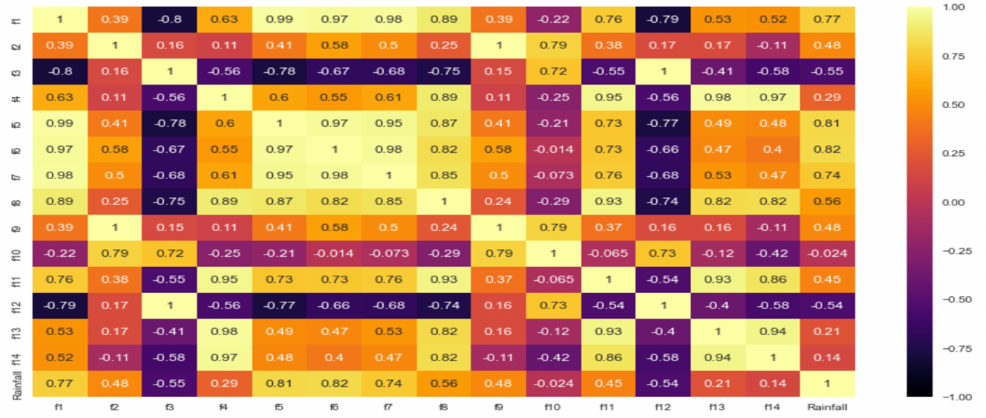
Figure 14. Correlation of features after feature engineering and data